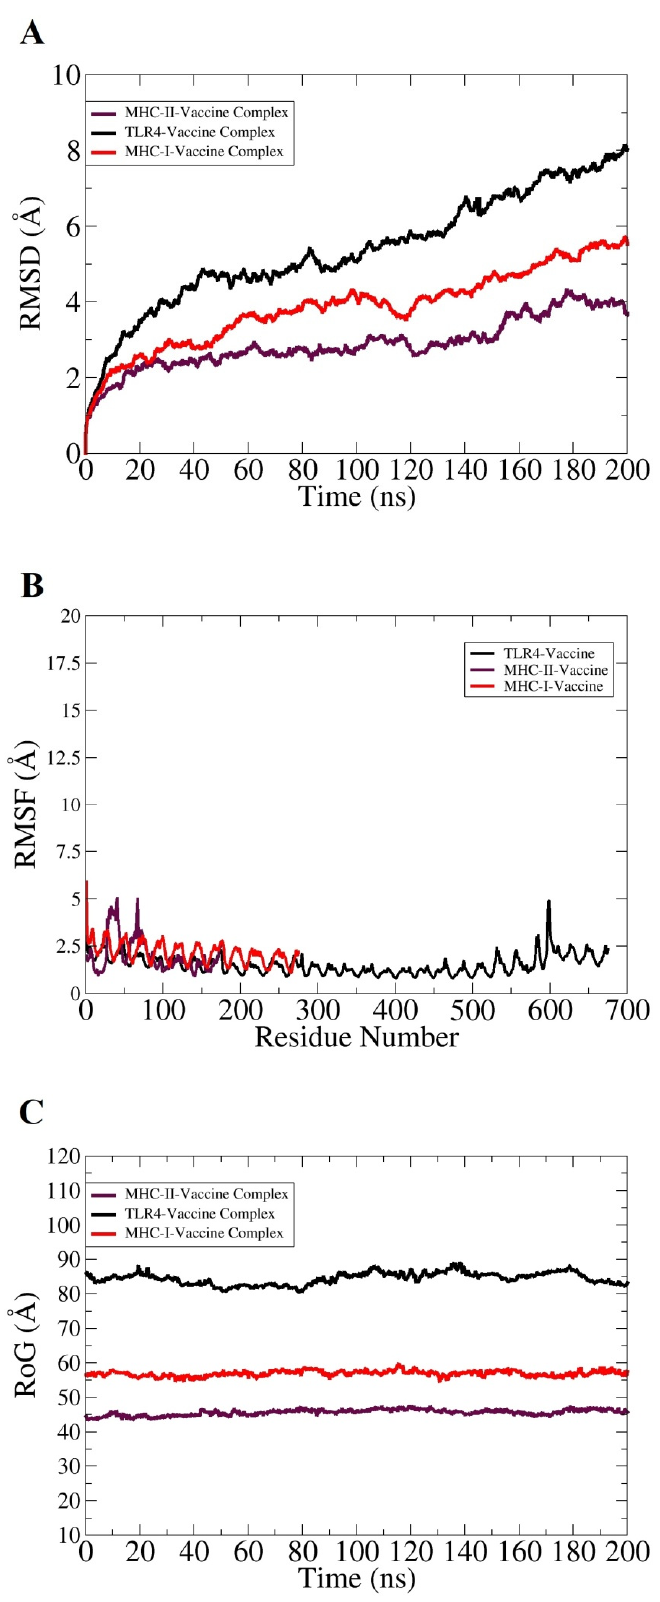
Figure 6. Structural stability analysis of complexes based on carbon alpha atoms: ( A ) RMSD, ( B ) RMSF, and ( C ) RoG.